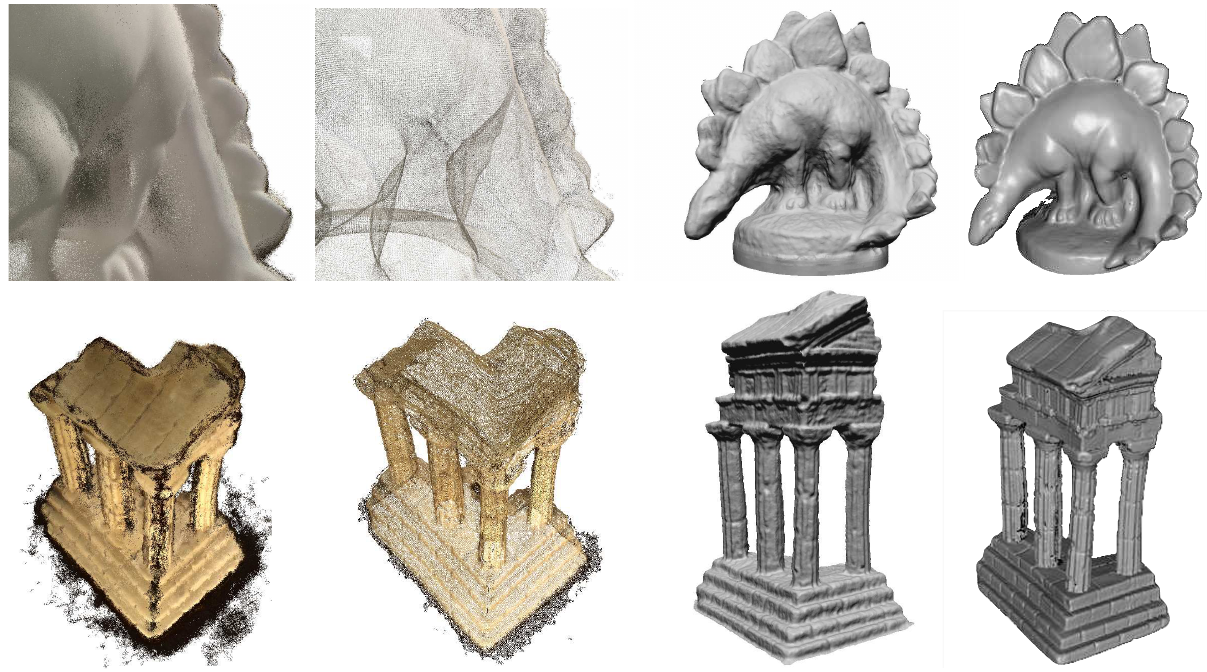
Figure 8: Results for the temple and dino data sets. From Left to right: raw point cloud; oriented points resulting from our method; mesh generated by Poisson reconstruction using our oriented points; ground-truth